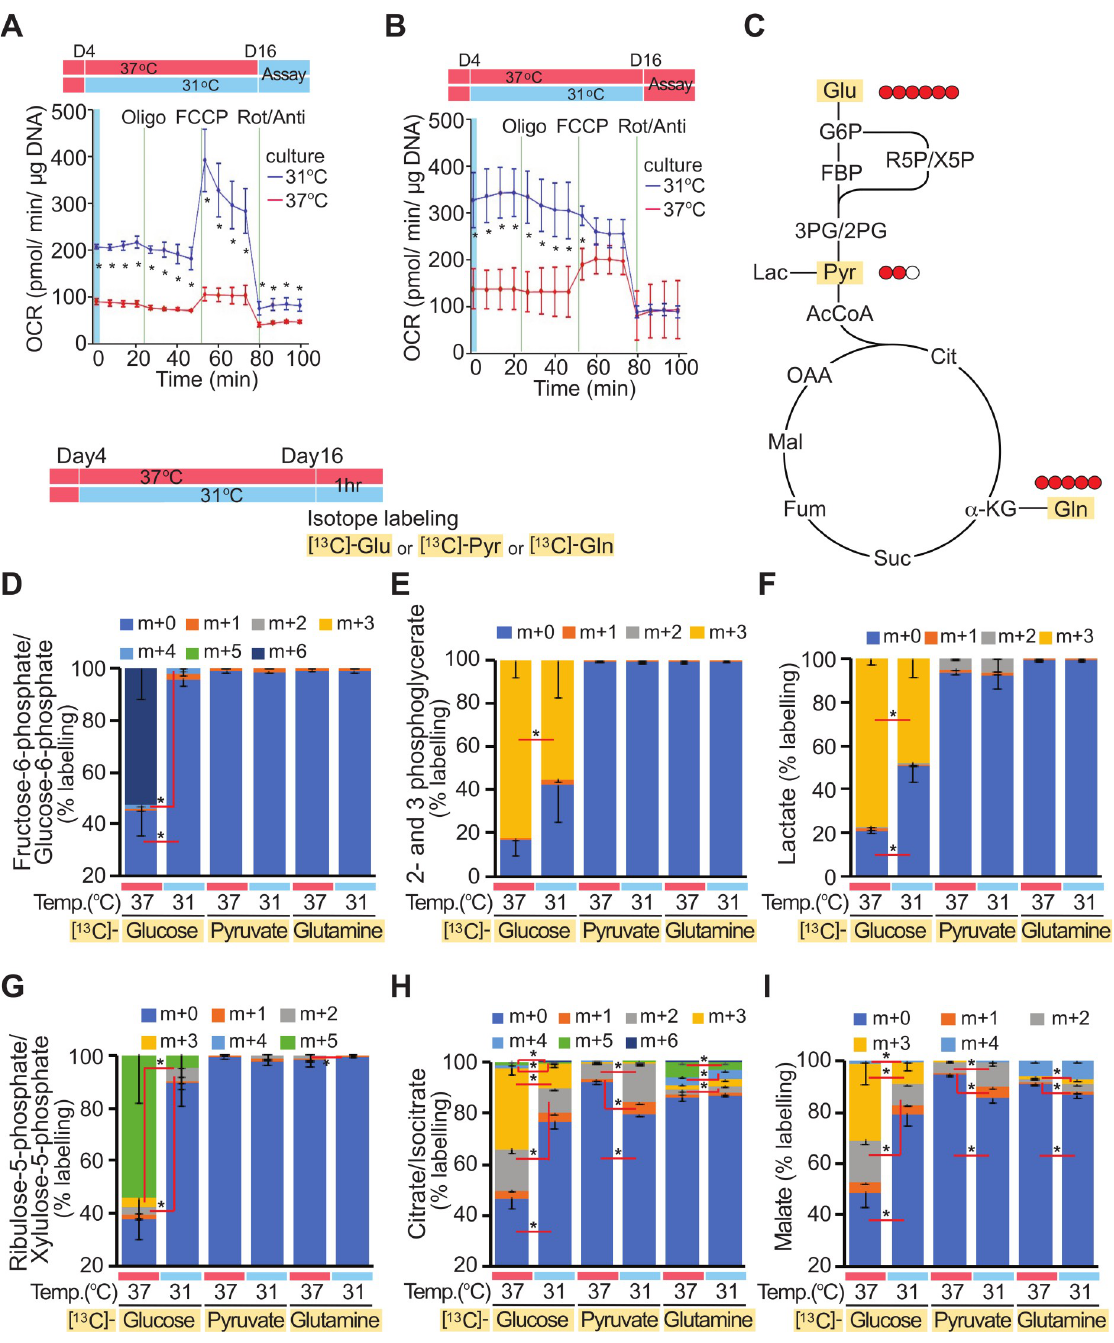
Fig 4. Adipocytes adapted to cooler temperatures have increased OCR and preferentially consume pyruvate and glutamine over glucose. ( A, B ) Seahorse XF96 Cell Culture Microplates were cut in half. Four days after adipocyte differentiation at 37˚C, adipocytes on one half of the plate were cultured at 31˚C and the other half at 37˚C for 12 days. After rejoining the plate, OCR was evaluated either at 31˚C ( A ) or 37˚C ( B ) ( n = 4). Data shown are representative of at least 3 independent experiments. ( C – I )Differentiated adipocytes cultured at either 37˚C or 31˚C for 12 days were incubated with [ 13 C]-glucose, [ 13 C]-pyruvate, or [ 13 C]-glutamine for 1 hour. Substrate concentrations in media were kept constant except for the substitution of [ 13 C]-metabolites (5 mM glucose, 0.2 mM pyruvate, and 1 mM glutamine). Color code indicates [ 13 C]-labeling on 0 through 6 carbons. Values are mean ± SD ( n = 3). � p < 0.05. Data shown are from one experiment. Uncropped western blots are provided in S1 Raw Images, and numerical data for all graphs are provided in S4 Data. OCR, oxygen consumption rate; Oligo, oligomycin; Rot/Anti, rotenone and antimycin.